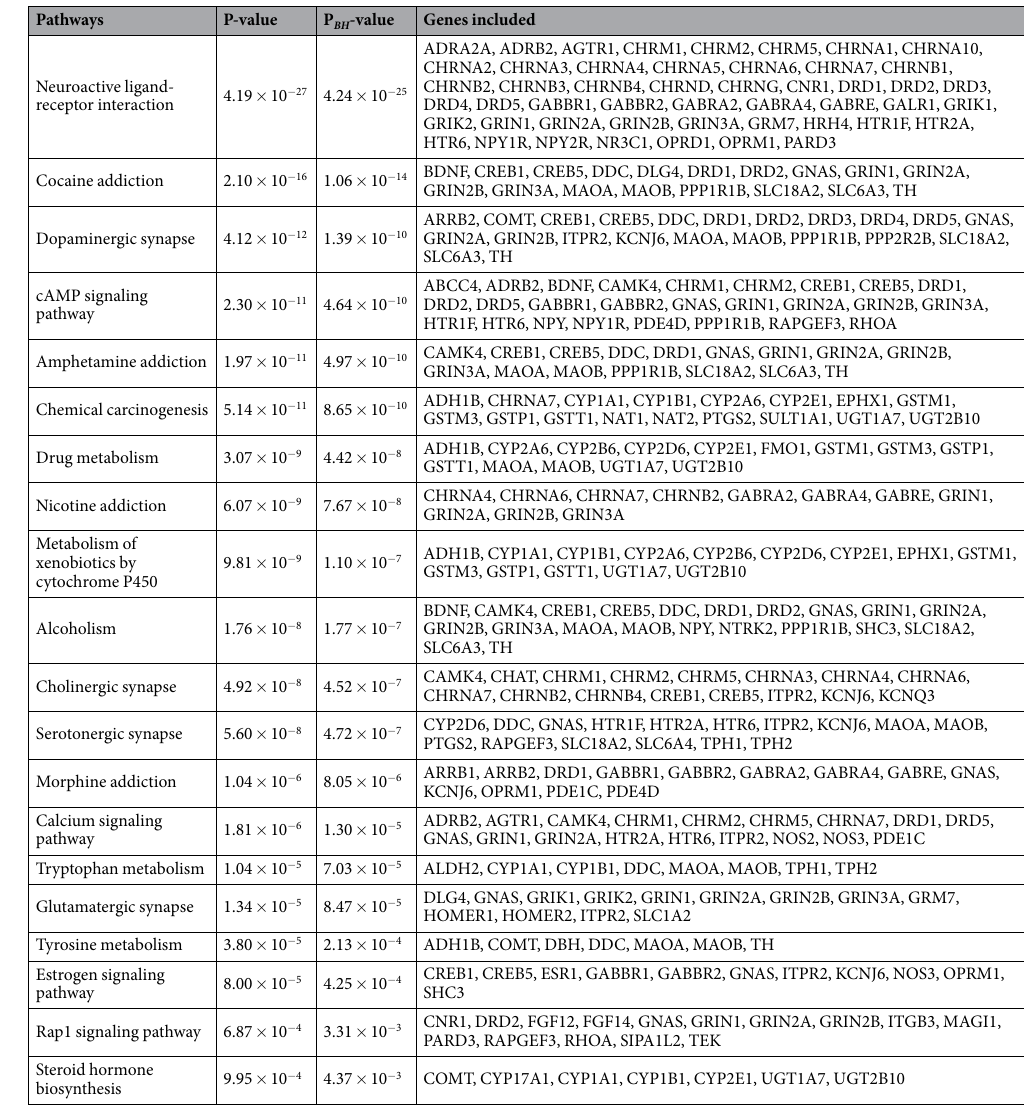
Table 1. Pathways Enriched in Genes Associated with Nicotine